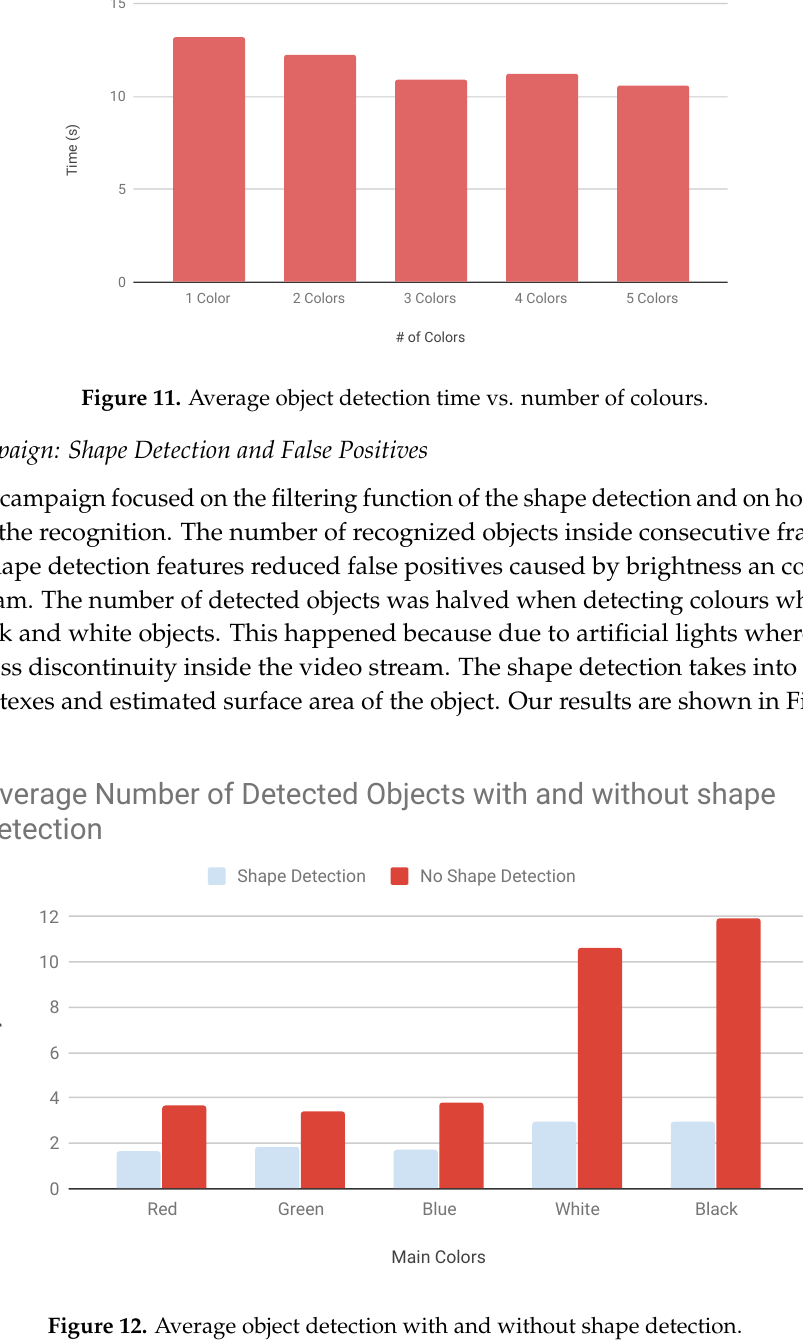
Figure 12. Average object detection with and without shape